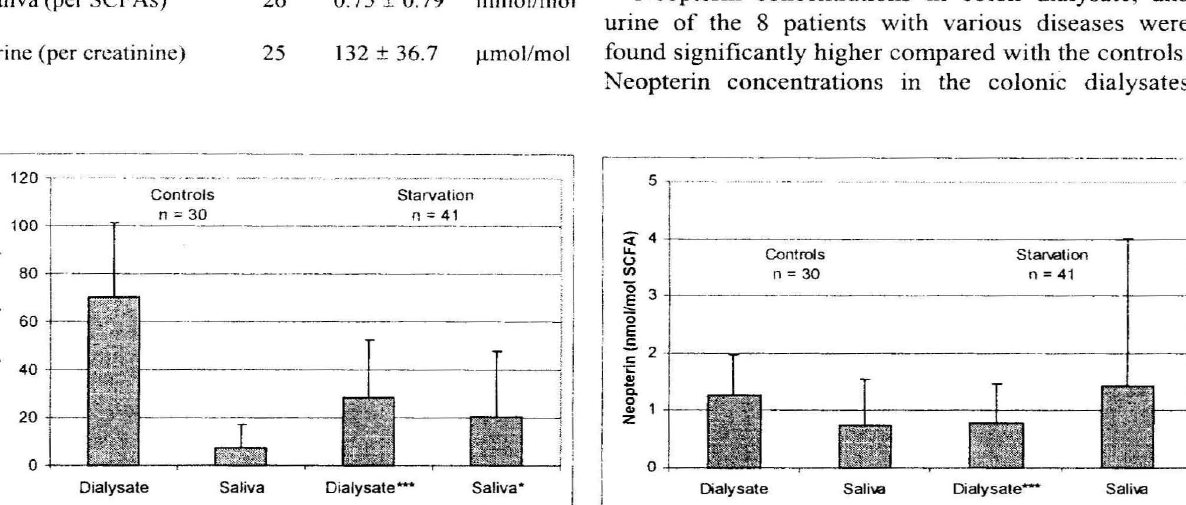
Figure 1. Concentrations ofneopterin (mean ± S.D.) in colon dialysate and in saliva of healthy individuals and of healthy subjects during a starvation diet (* p < 0.05; *** p < 0.001 when compared with controls) (14,16), colon dialysate is about 10 times higher and urinary neopterin is 200 times higher (2,14). As with urine, in colon dialysates and saliva a physiologically fluctuating water content has to be taken under consid eration. For this purpose, in urinary specimens usually the neopterin per creatinine quotient is calculated (1).